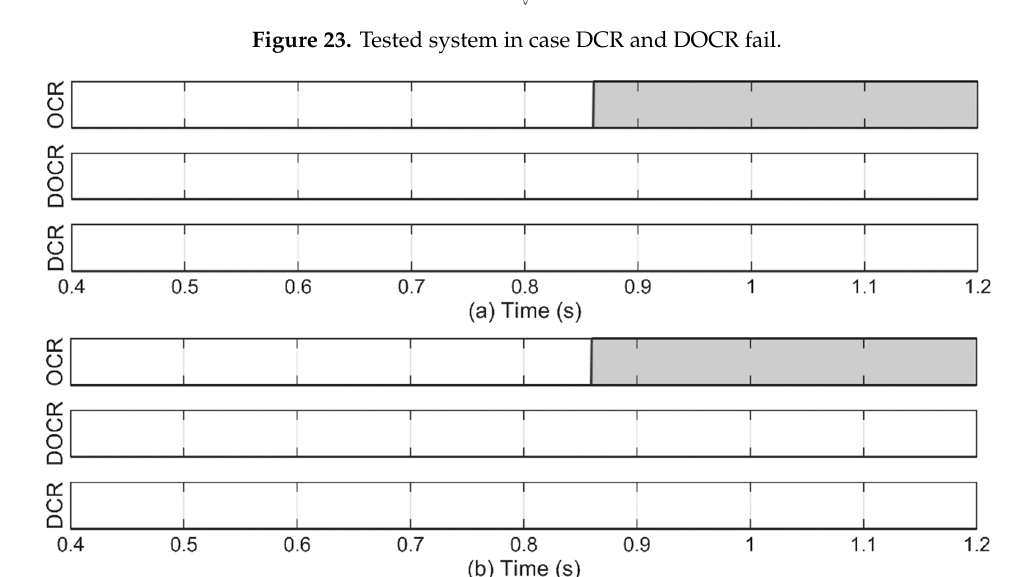
Figure 23. Tested system in case DCR and DOCR fail.